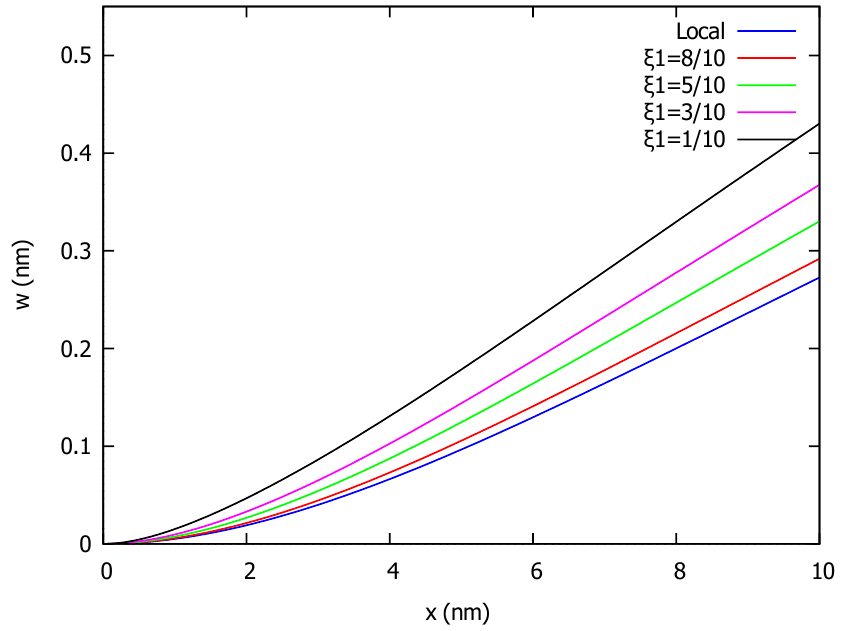
the beam loaded by a variable distributed load q ( x ) of the above type with n = 3 is shown in Figure 6 for different values of τ .